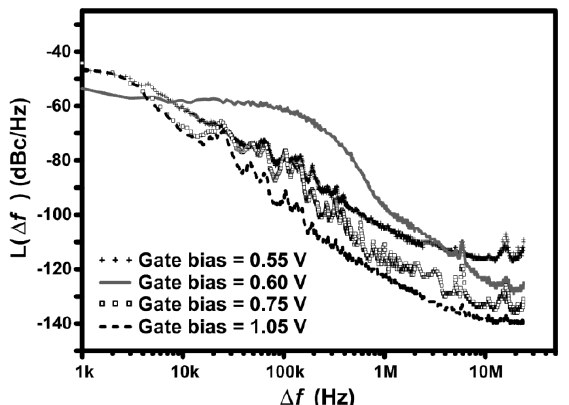
Figure 11. Measured phase noise of the 2.4 GHz design for various tail current source control voltages applied to transistor M , at a supply voltage of 1.5 5